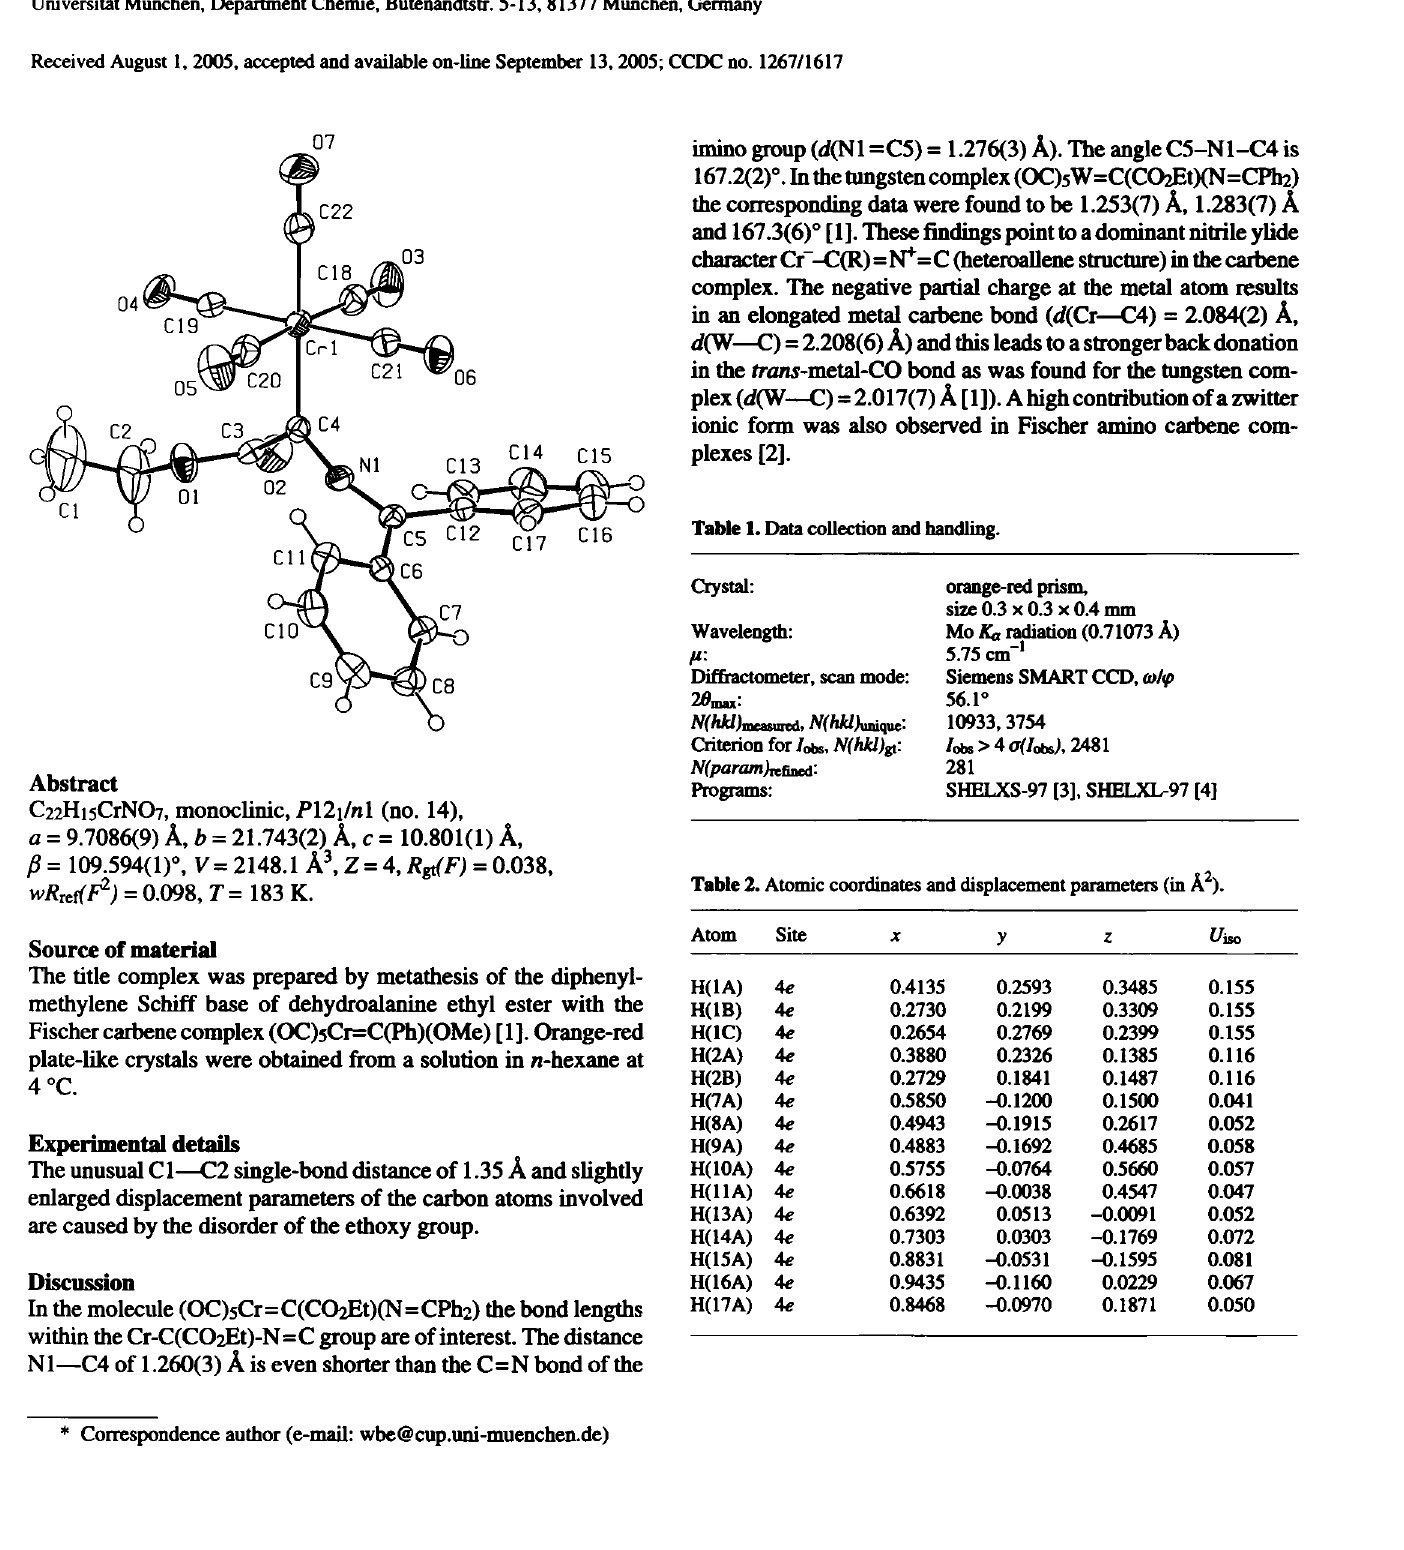
Table 1. Data collection and handling.